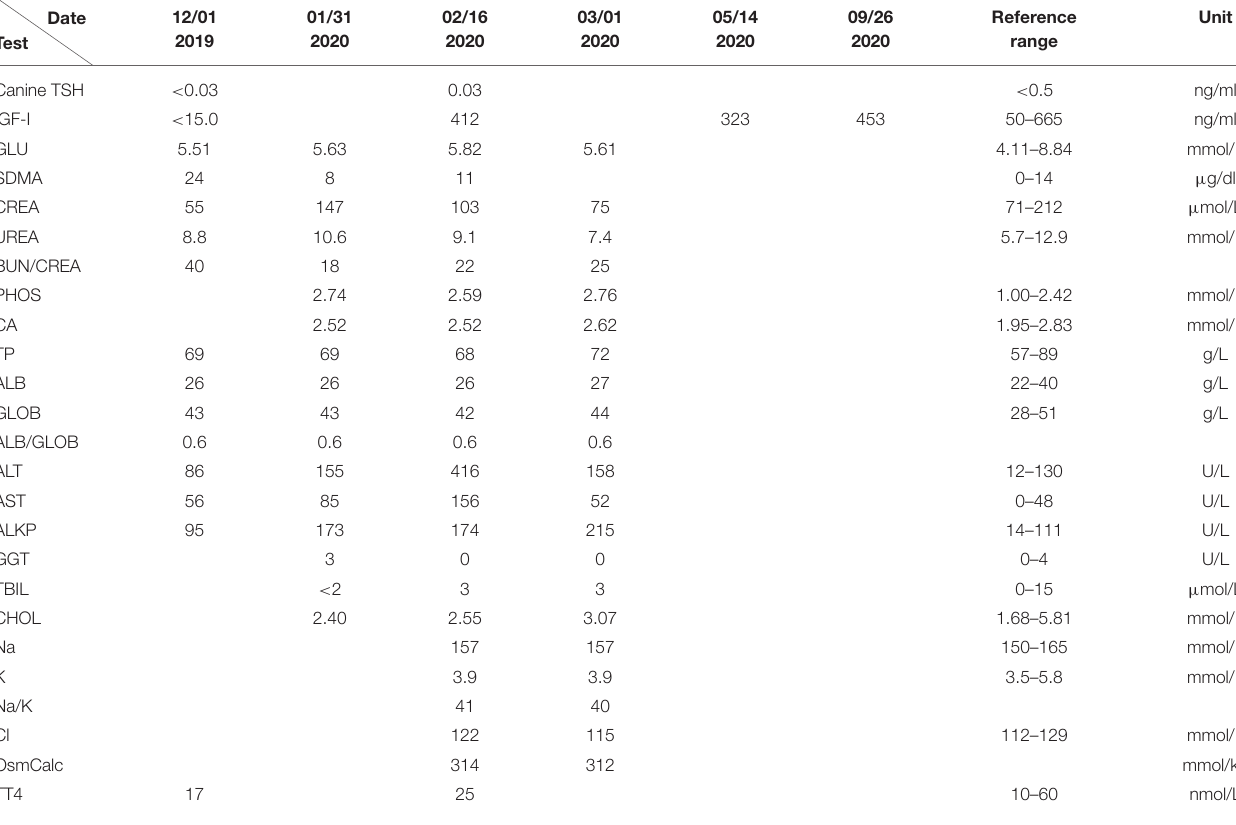
TABLE 1 | Blood biochemistry